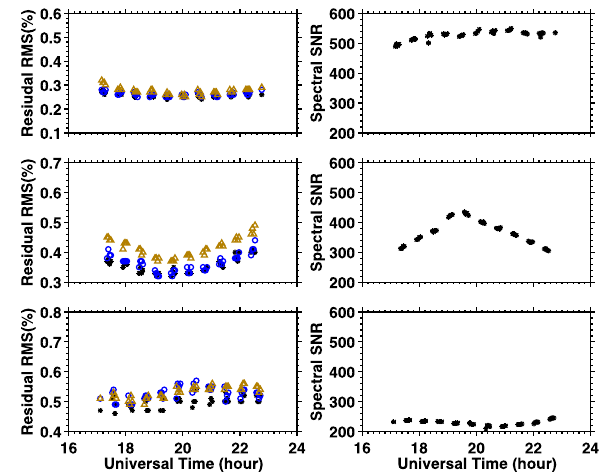
Figure 9 . Root Mean Square (RMS) of spectral fitting residuals (left panels) and spectral 2 Fig. 9. Root mean square (RMS) of spectral fitting residuals (left SNR (right panels) as a function of time for the measurements of CH 4 and O 2 column 3 densities in Spectralon viewing geometry (top panels); over the Arcadia Race Track (middle 4 panels) and spectral SNR (right panels) as a function of time for panels); over west Pasadena (bottom panels). Three spectral bands centered at 5938 cm -1 5 the measurements of CH 4 and O 2 column densities in Spectralon ® (black stars, noted as MW5938 thereafter), 6076 cm -1 (blue circles, noted as MW6076 6 thereafter) and 7885 cm -1 (gold triangles, noted as MW7885 thereafter) are presented, 7 viewing (top panels), over the Santa Anita Park (middle panels), respectively. The spectral SNR were nearly identical over the three spectral bands in a 8 measured spectrum, but varies among spectra. The measurements were performed on January 9 and over west Pasadena (bottom panels). Three spectral bands 3 rd , 2013. The spectral fitting residuals were normalized by the spectral continuum levels 10 centered at 5938cm − 1 (black stars, noted as MW5938 there- prior to the computation of RMS values. The spectral fitting residuals were dominated by the 11 photon shot noise. The Chi-squared tests of spectral fitting residuals yielded values generally 12 after), 6076cm − 1 (blue circles, noted as MW6076 thereafter) and within 1.3. 13 7885cm − 1 (gold triangles, noted as MW7885 thereafter) are pre- sented. The spectral SNRs were nearly identical over the three spec- tral bands in a measured spectrum, but vary among spectra. The measurements were performed on 3 January 2013. The spectral fit- ting residuals were normalized by the spectral continuum levels prior to the computation of RMS values. The spectral fitting residu- als were dominated by the photon shot noise. The chi-squared tests of spectral fitting residuals yielded values generally within